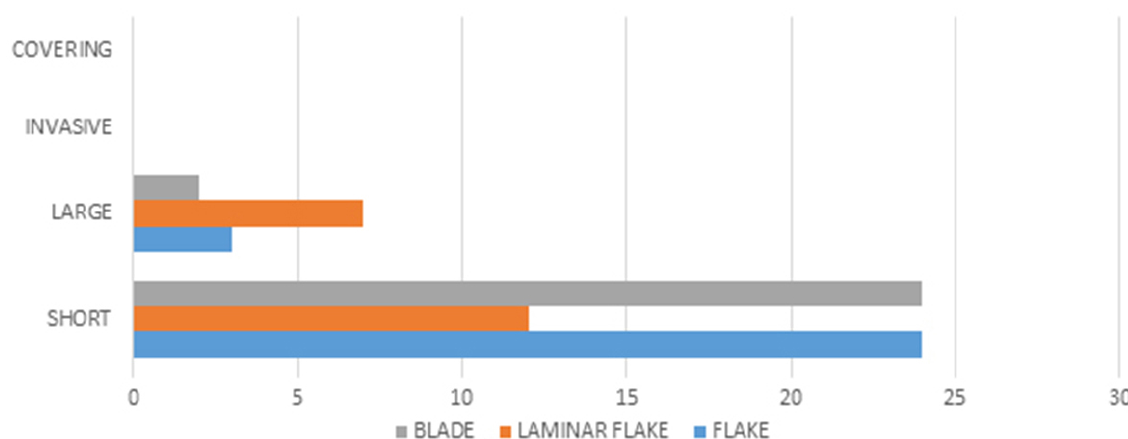
Figure 12. Representation of the extension of the retouch from the retouched material.